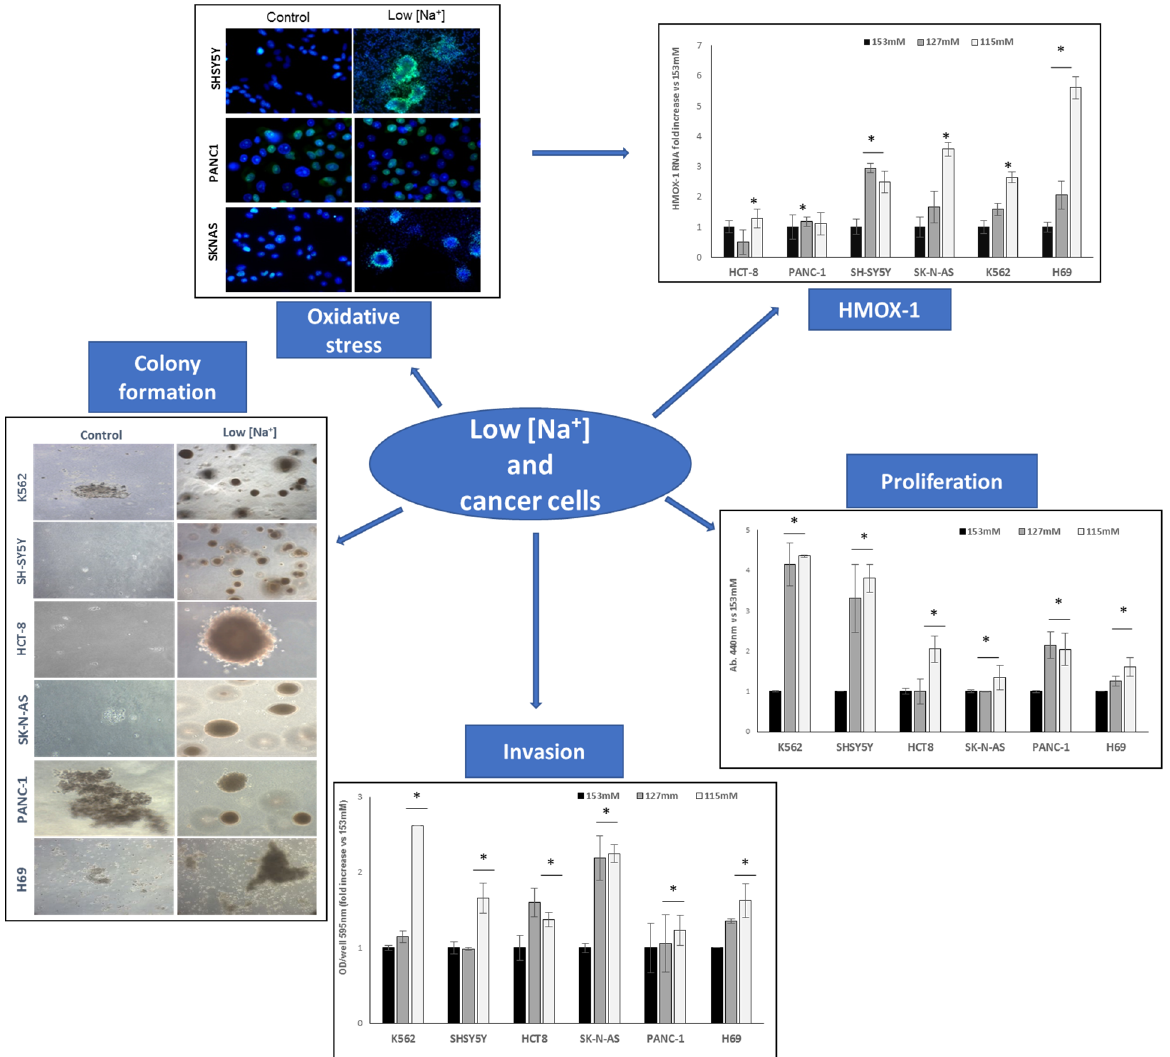
Figure 1. Different features of cancer cell lines cultured in normal extracellular [Na + ] vs. low [Na + ]. *: p < 0.05. *: p ≤